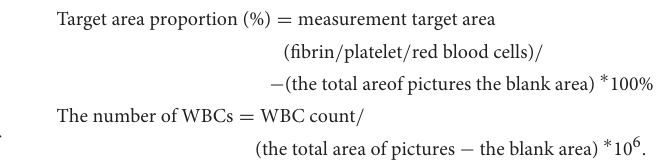
Primary antibodies against CD31 were added and incubated for 22 min at normal temperature, followed by streptavidin- peroxidase conjugation and incubation for 22 min. The sections were counterstained with hematoxylin, dehydrated in increasing grades of ethanol, cleared in xylene and mounted. For the H&E staining images, red represents red blood cells; pink regions represent fibrin; and blue dots represent WBCs. platelets, and other components are not colored ( Figure 1